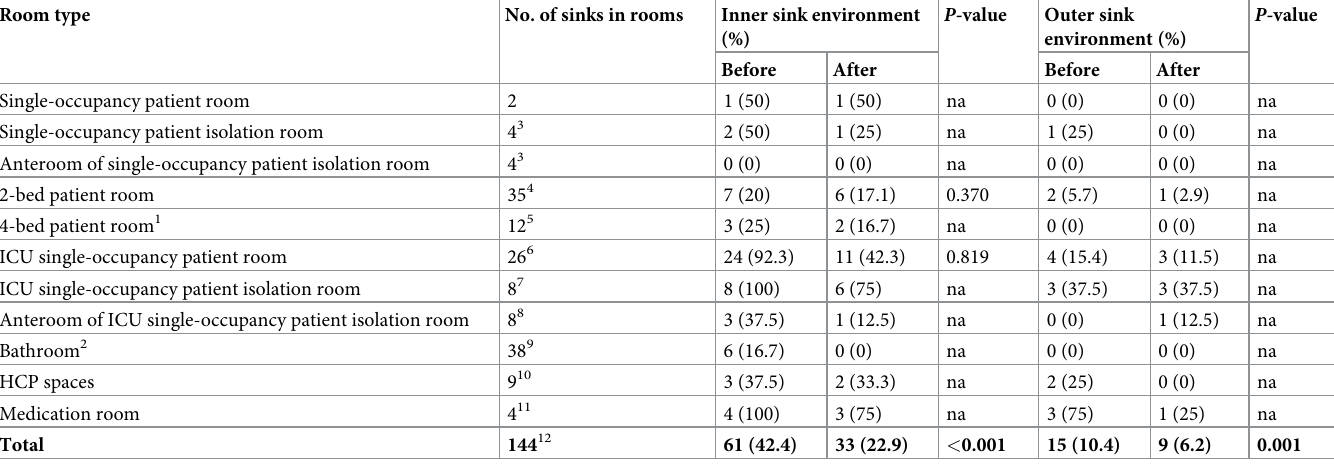
Table 1. Before-and-after analysis of VIM-PA cultured in the inner and outer sink environments. Percentages of VIM-PA-positive samples are shown per room type. Room type